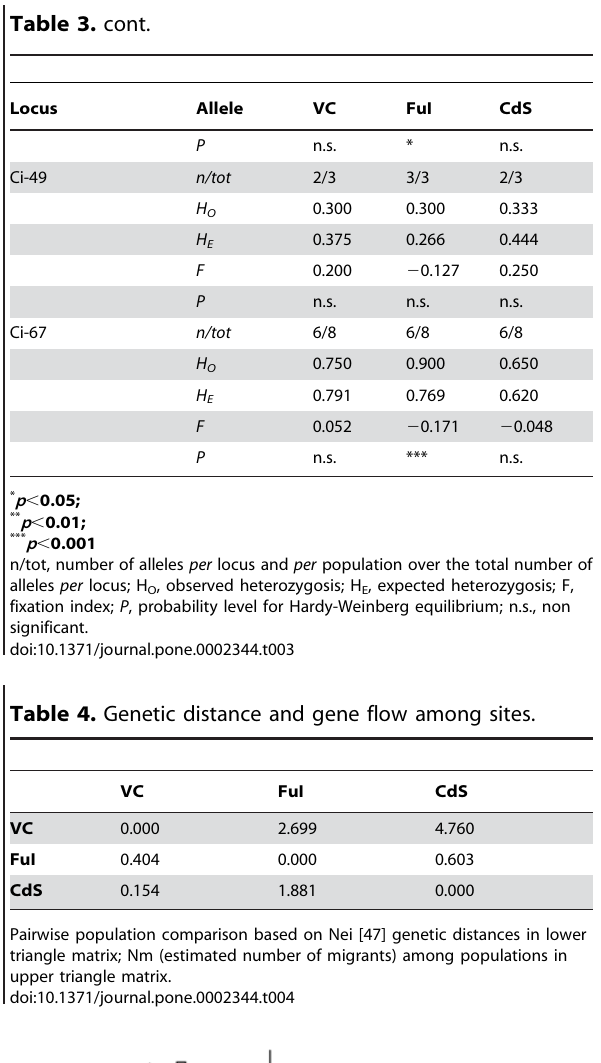
Table 3. Genetic characterization based on twelve nuclear microsatellite loci.